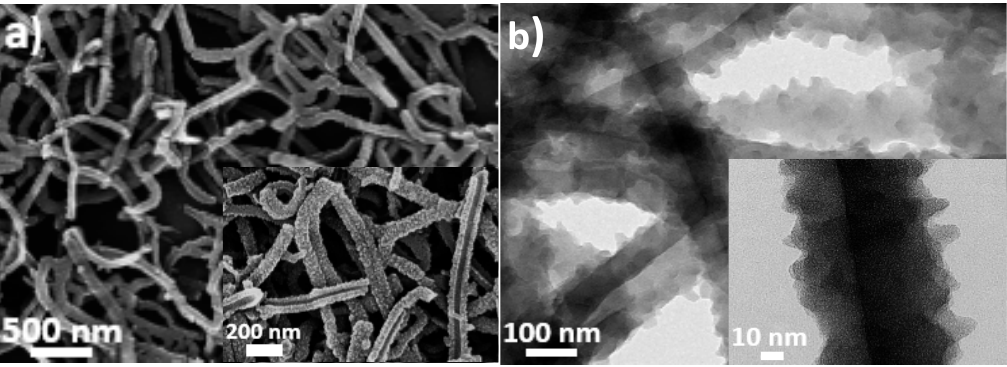
Figure 1. ( a ) SEM and ( b ) TEM images for polyaniline (PANI) obtained by using cetyl trimethyl ammonium bromide (CTAB) as template and ammonium persulfate (APS) as oxidative